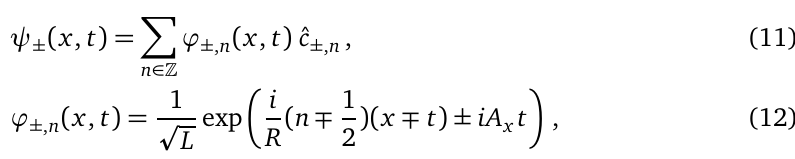
Figure 1: Energy levels of the Dirac fermion and Fermi energy E state filling. Right panel: Filling after adiabatic insertion of one flux quantum, with arrows showing the spectral